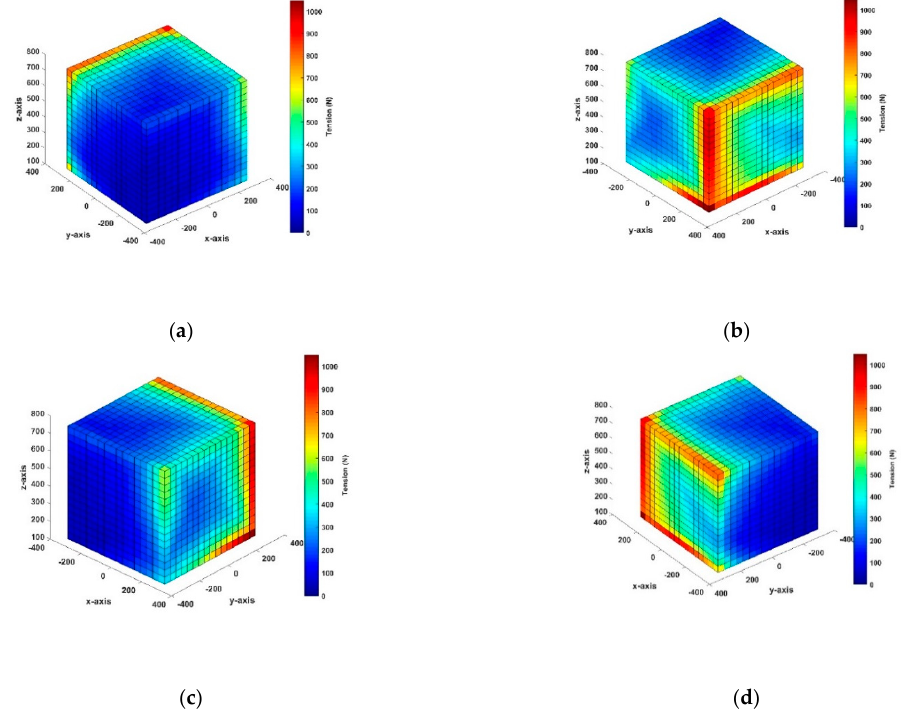
Figure 8. Overall workspace simulation at the acceleration of 100 m/s 2 : ( a ) front plane of the X –axis; ( b ) back plane of the X –axis; ( c ) front plane of the Y –axis; ( d ) back plane of the Y -axis.